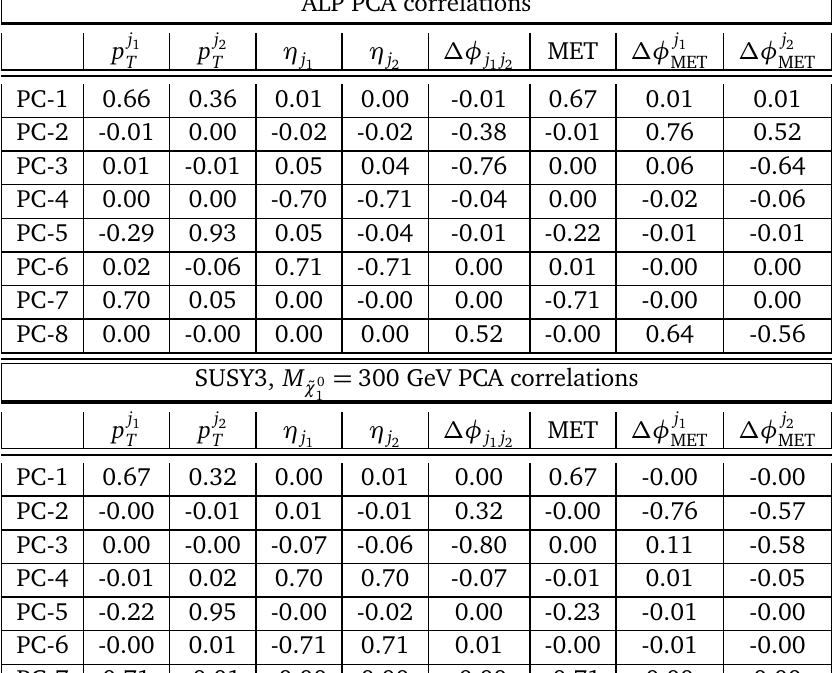
Table 2: PCA original feature to principal component correlations for the ALP and SUSY3 benchmark (rounded to 2